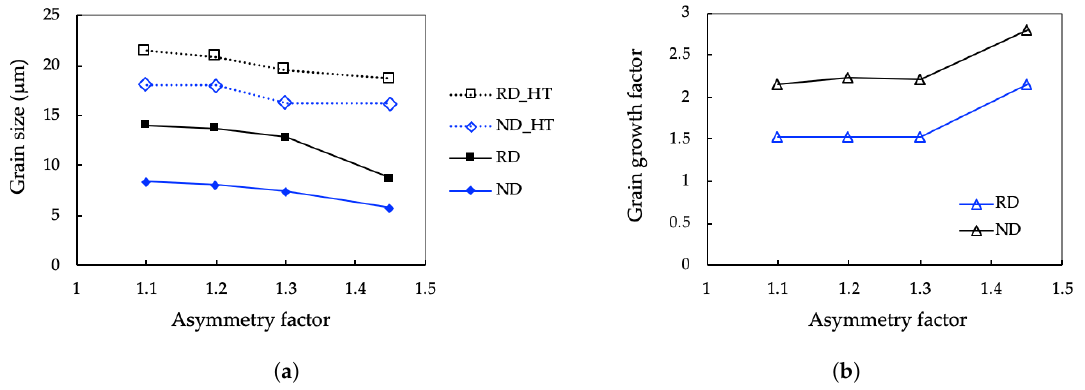
Figure 7. Grain refinement in function of asymmetry factor: ( a ) grain size and ( b ) grain growth by annealing at 700 ◦ C for 30 min. Data from